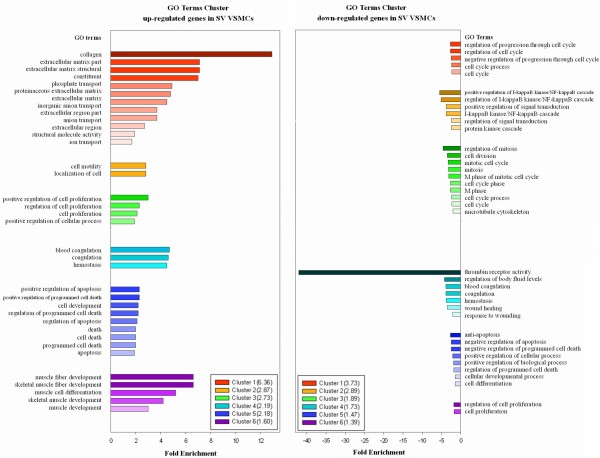
GO terms cluster of up-regulated and down-regulated genes in SV VSMCs.Fold Enrichment (FE): To measure the magnitude of enrichment. For example, 10% of analysis genes are kinases versus 1% of genes in human genome (this is population background) are kinases. Thus, the fold enrichment is tenfold. Fold enrichment 1.5 and above are considered as statistical significance. Negative value means that the GO term was down-regulated in SV VSMCs. GO Terms: A detailed GO item in the annotation source of DAVID system. Each set of color bars represents a annotation term group(cluster). Values in brackets was Enrichment Score (ES) of each cluster : To rank overall importance (enrichment) of annotation term groups. It is the geometric mean of all the enrichment P-values (EASE scores) of each annotation term in the group. To emphasize that the geometric mean is a relative score instead of an absolute P-value, minus log transformation is applied on the average P-values. ES > 1.3-fold (equivalent to non-log scale 0.05) was considered as statistical significance, mean that the gene cluster was significantly enriched in analysis list. P-value (or called EASE score, for individual term members): To examine the significance of gene–term enrichment with a modified Fisher’s exact test (EASE score). P <0.05 was considered as statistical significance.